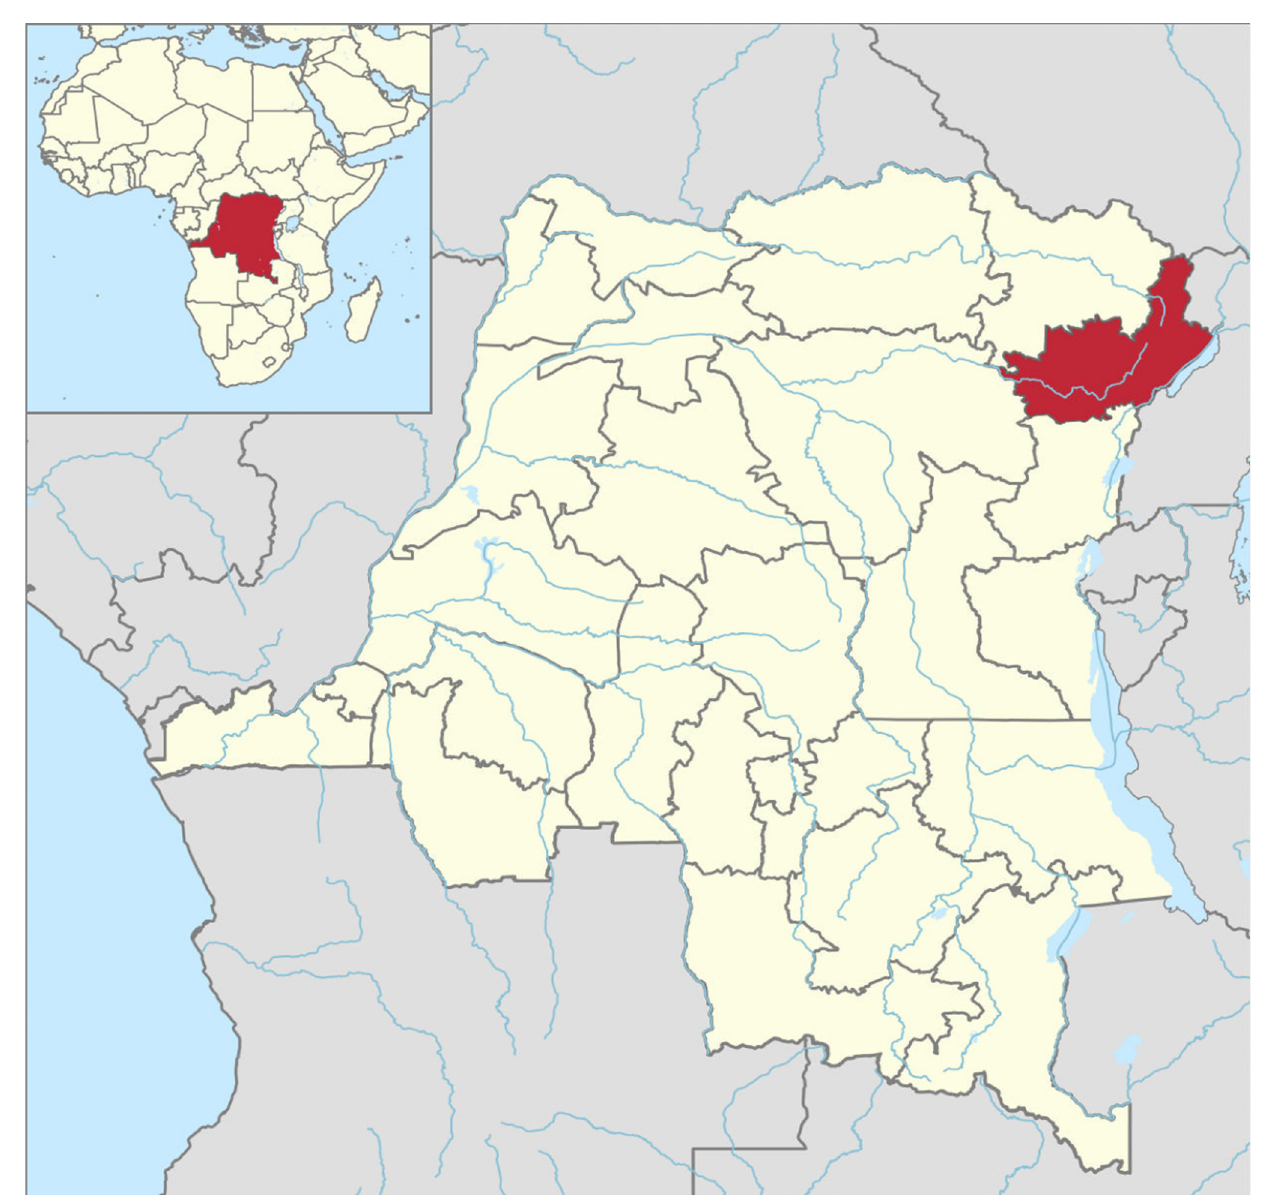
Fig 1. Study site: Ituri province map in the north-eastern of DRC. Map of the north-eastern of the Democratic Republic of the Congo in the centre of Africa, and the Ituri province. Map created by Oleksii Morozov based on geo data obtained from https://data.humdata.org/dataset/f42132b9-8cc6- 4201-b020-9259c56e8868/resource/e335bc0b-b946-437f-b771-beb5599eaf1d/download/cod_admbnda_rgc_itos_20190911_shp.zip and https://www. naturalearthdata.com.